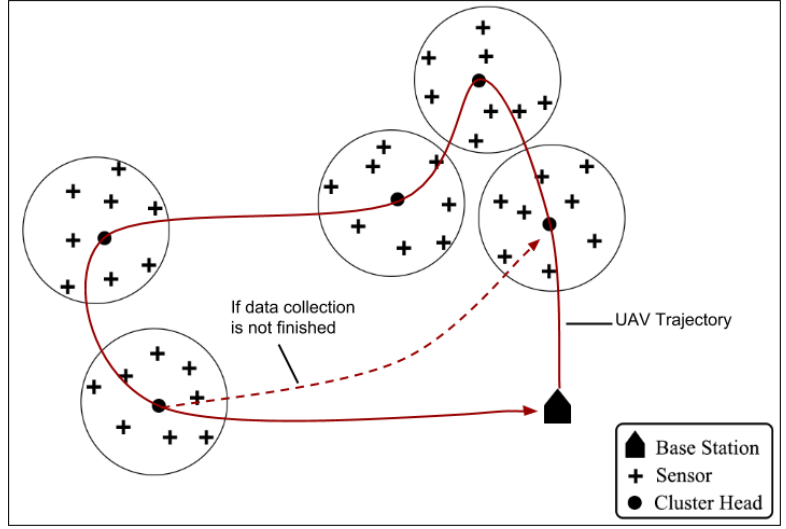
Figure 12. Simulation scenario: UAV flies over 45 nodes organized into five